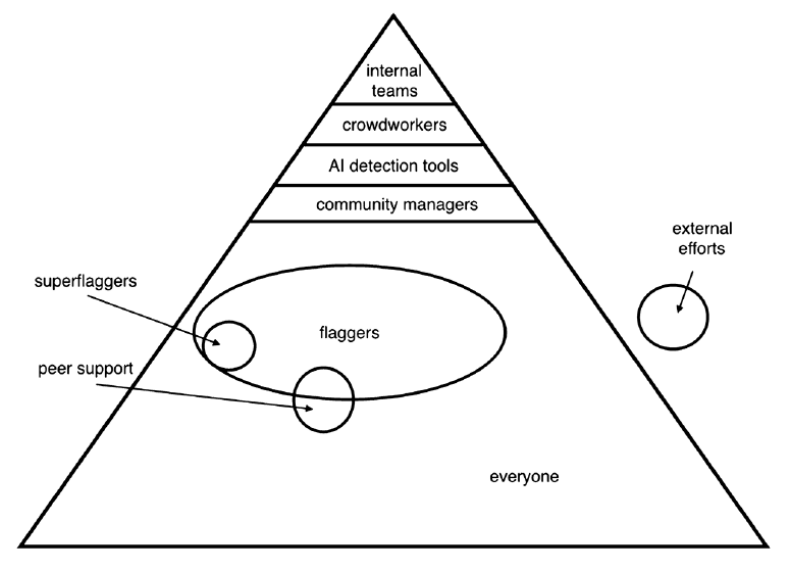
Figure 1: Pyramid of participants in content management (Source: Gillespie